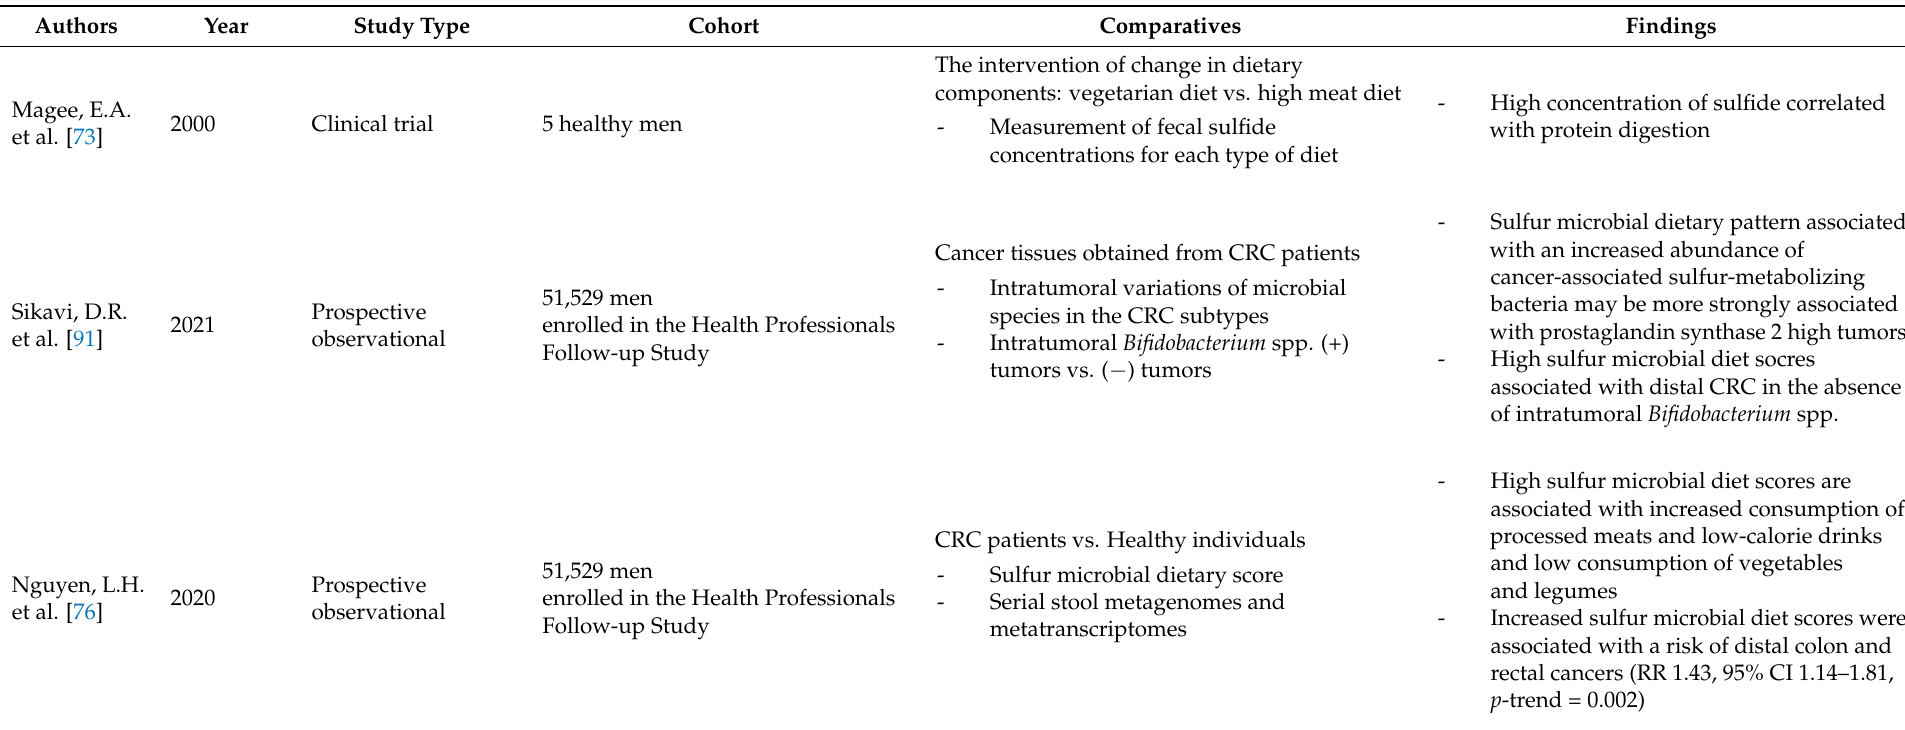
Table 2. Clinical studies are evaluating the association between the sulfur microbial diet and